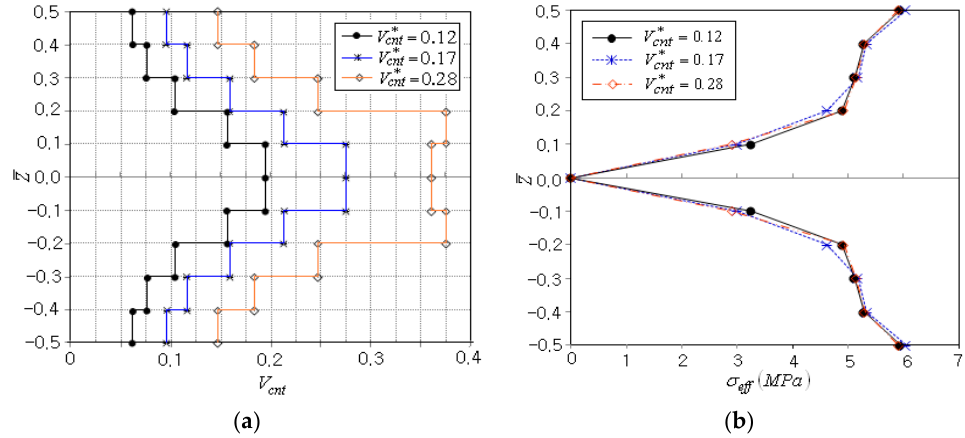
Figure 6. Comparison between the volume fractions * cnt V : ( a ) CNT distribution, ( b ) effective stress distribution σ eff